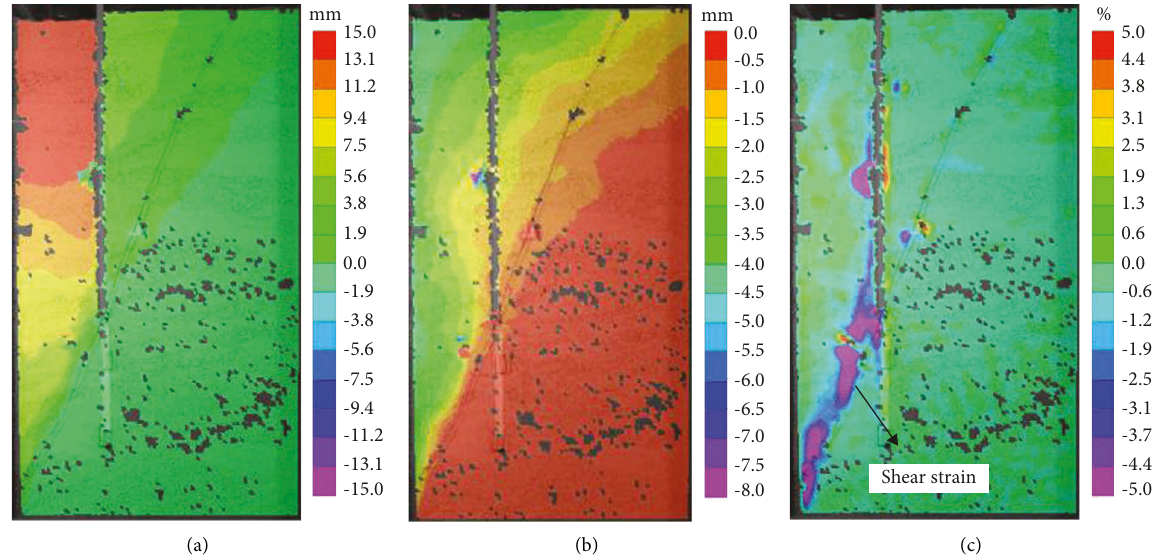
Figure 12: The ground displacement in sample M3; (a) the vertical settlement, (b) the horizontal displacement, and (c) the shear strain.